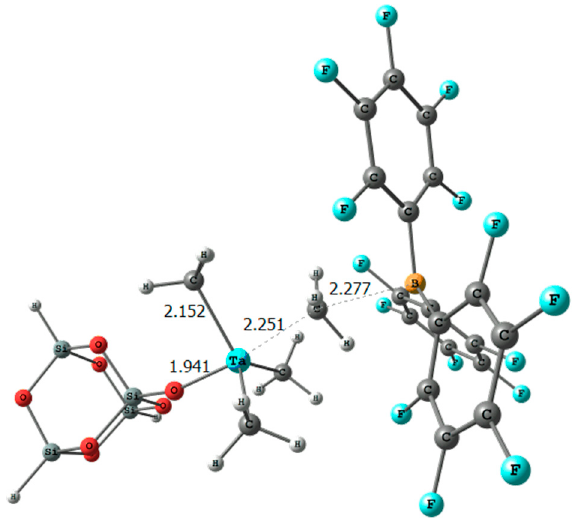
Figure 5. Transition state for the demethylation by B(C 6 F 5 ) 3 of ( ≡ Si-O-)TaMe 4 , main distances are shown in Å.